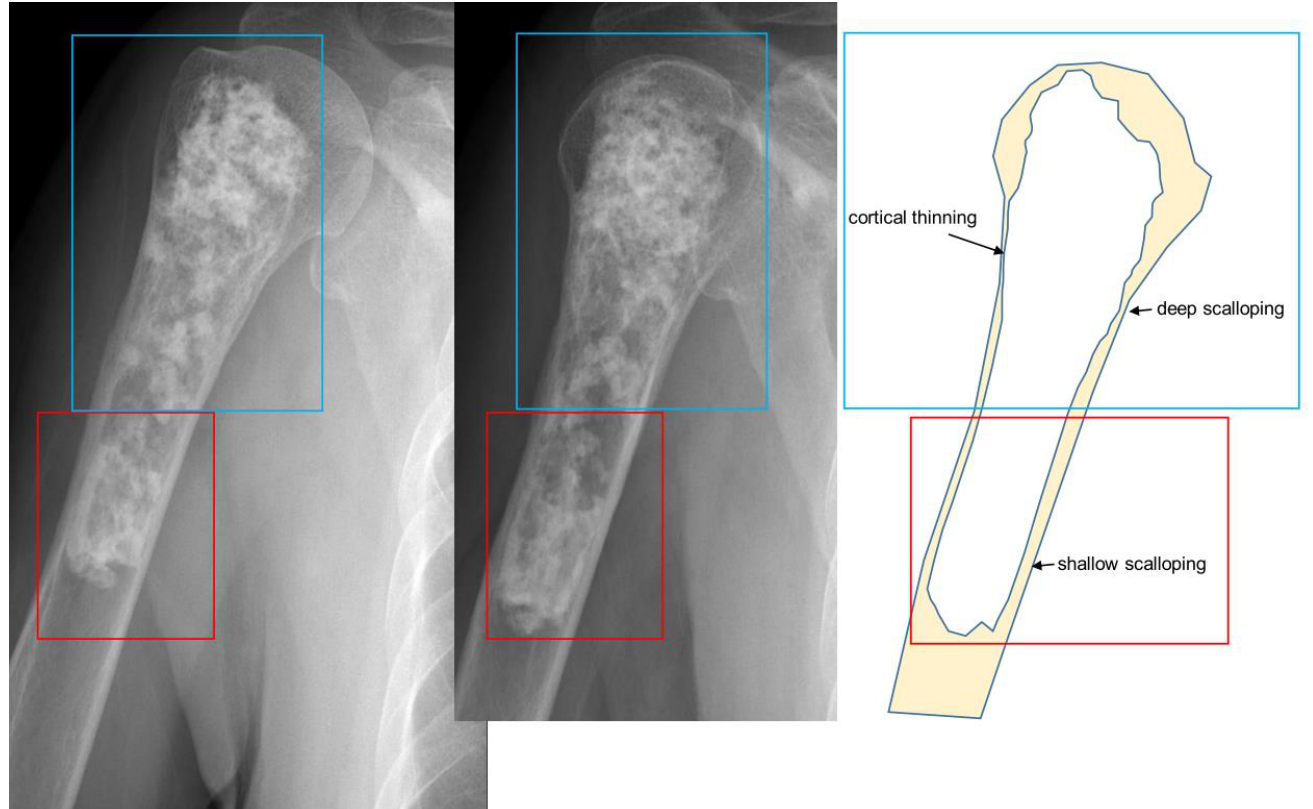
Figure 10. Secondary central chondrosarcoma of the humerus in an 81-year-old woman. The residual enchondroma in the red box (narrow scalloping) is combined with the additional features of chondrosarcoma in the blue box (cortical thinning and deep scalloping).